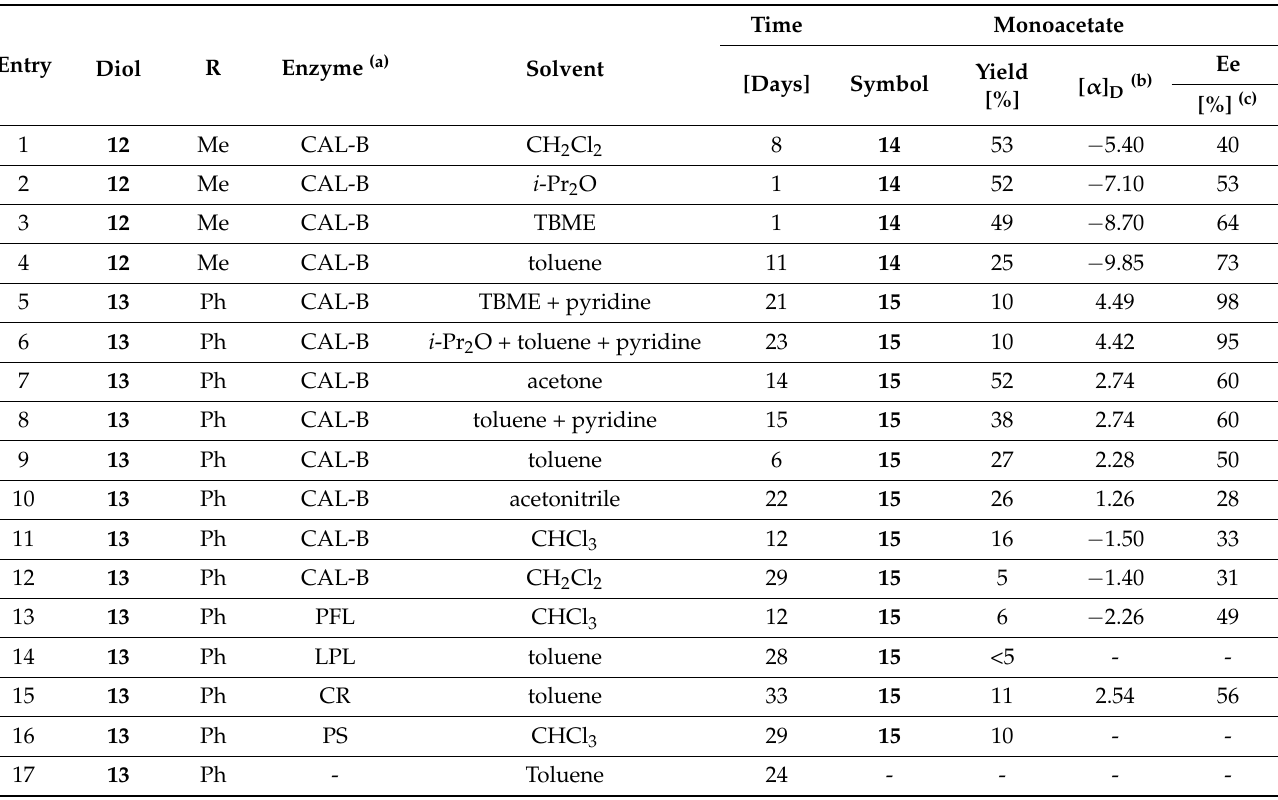
Table 1. Monoacetates 14 and 15 via Desymmetrisation of bis (2-hydroxymethylphenyl)phosphines 12 and 13 .